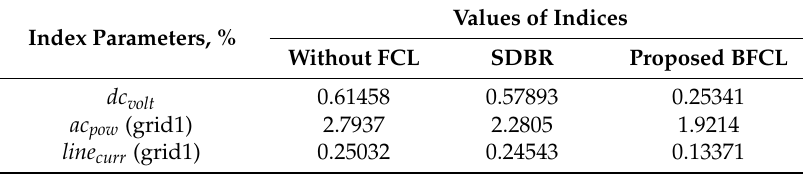
Table 6. Performance index improvement with the proposed BFCL for a 2LG fault (two grids-connected VSC-HVDC